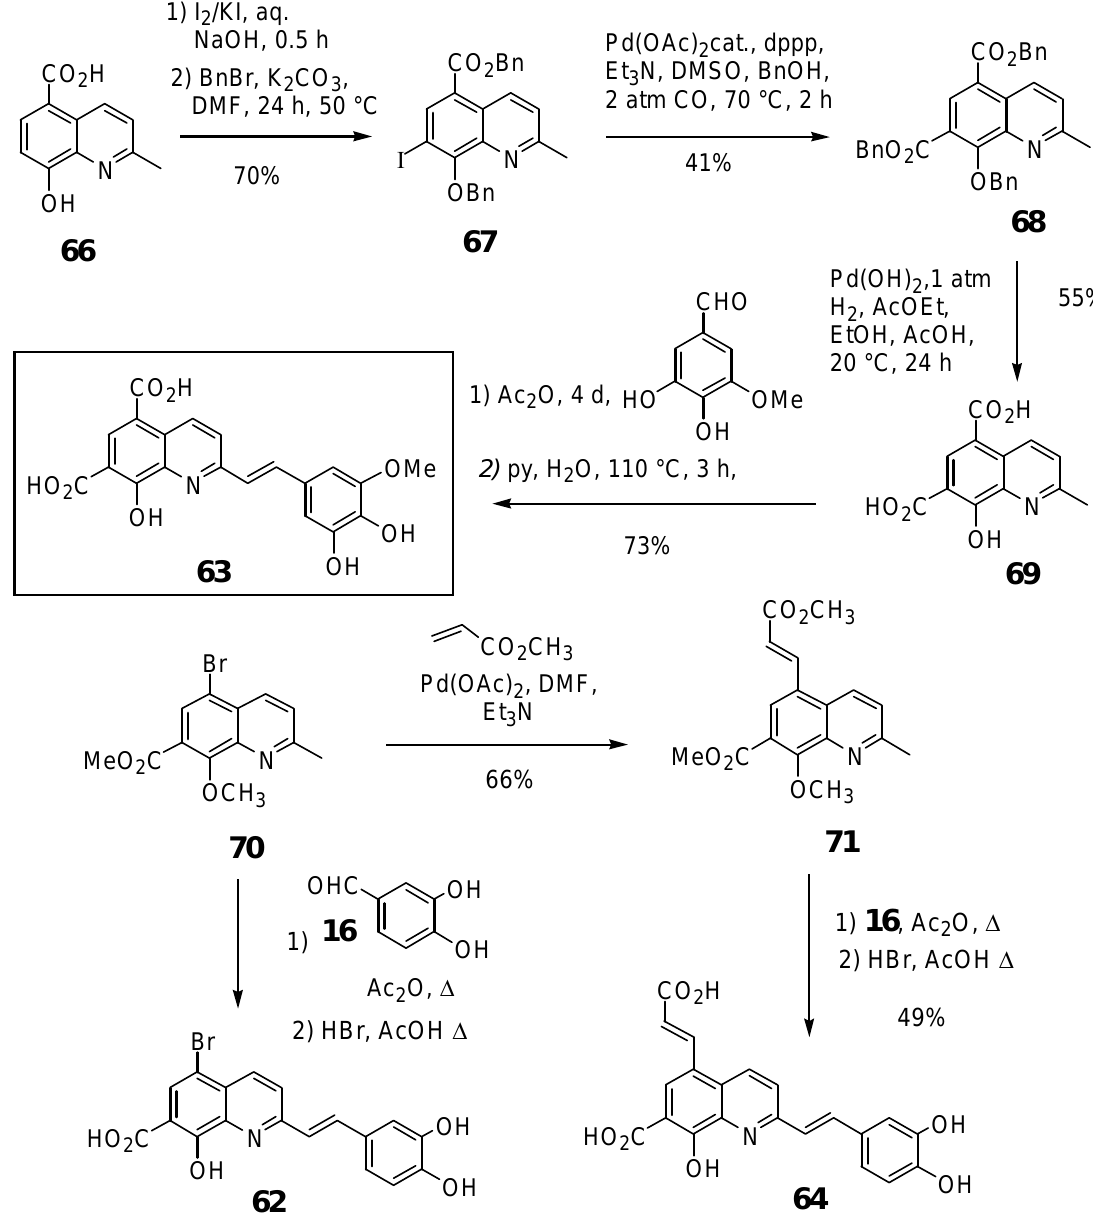
Scheme 7. Synthesis of C-5 functionalized styrylquinolines 62 and 64